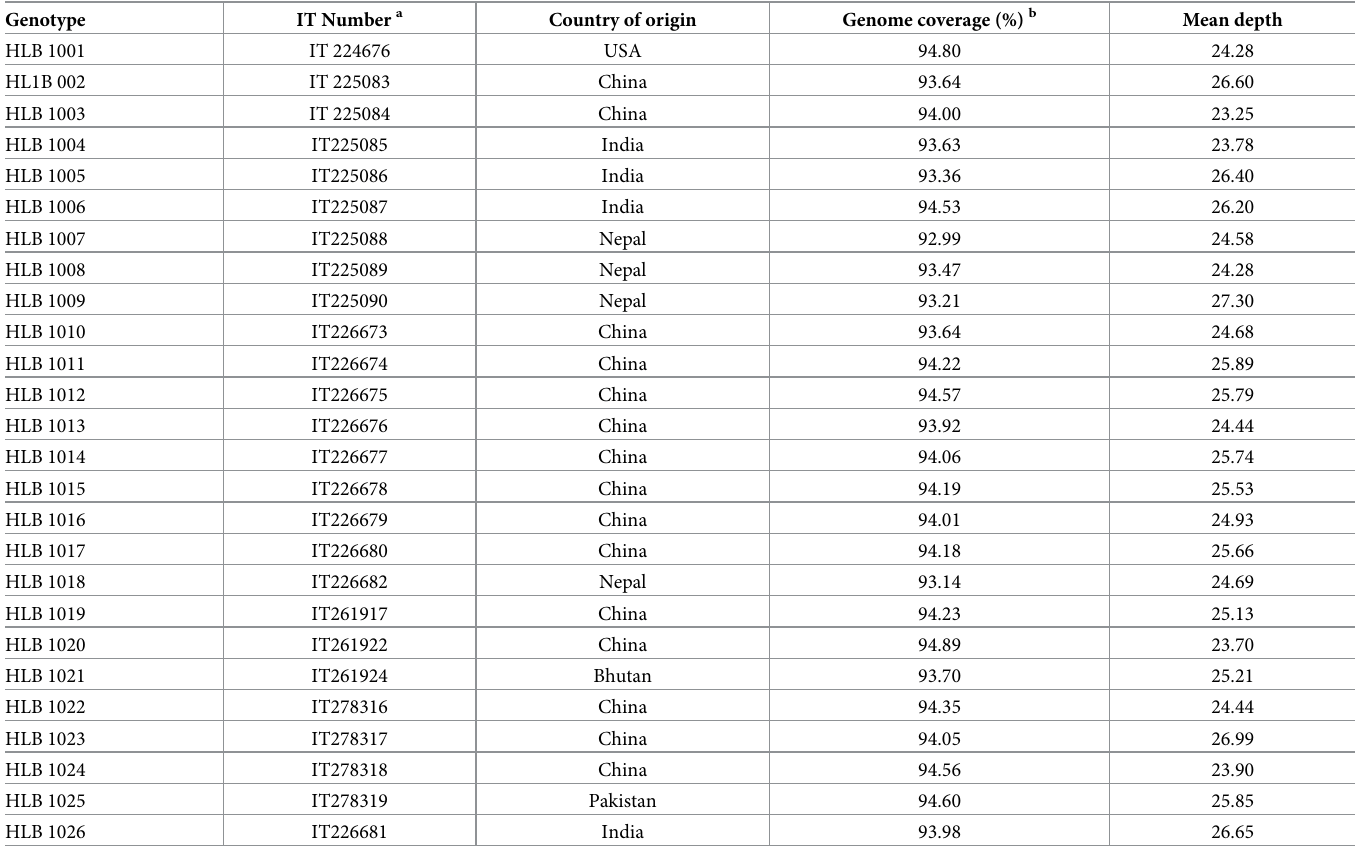
We selected 26 tartary buckwheat accessions for whole-genome resequencing. These acces- sions originated or were popularized in different Asian and international regions, including 15 landraces from China, 4 from Nepal, 4 from India, 1 from the USA, 1 from Bhutan and 1 from Pakistan (Table 2). After 3 additional generations were grown using the SSD method, a panel of the 26 genotypes showed a broad extent of rutin content and phenotype variation (Figs 1 and 2). The 26 accessions showed a various distribution of rutin content compared to those of the 73 accessions (Fig 2). In particular, HLB1013 had the highest rutin content (1,921 mg/100g � DW), while HLB1006 had the lowest (1,250 mg/100g � DW) among the 26 accessions. Large differences were found in seed shape and seed coat color among the 26 accessions (Fig 1). Seed information conformed to the known the genetic variation of the 26 accessions. Table 2. Genome coverage and mean depth after the whole genome resequencing of 26 accessions.